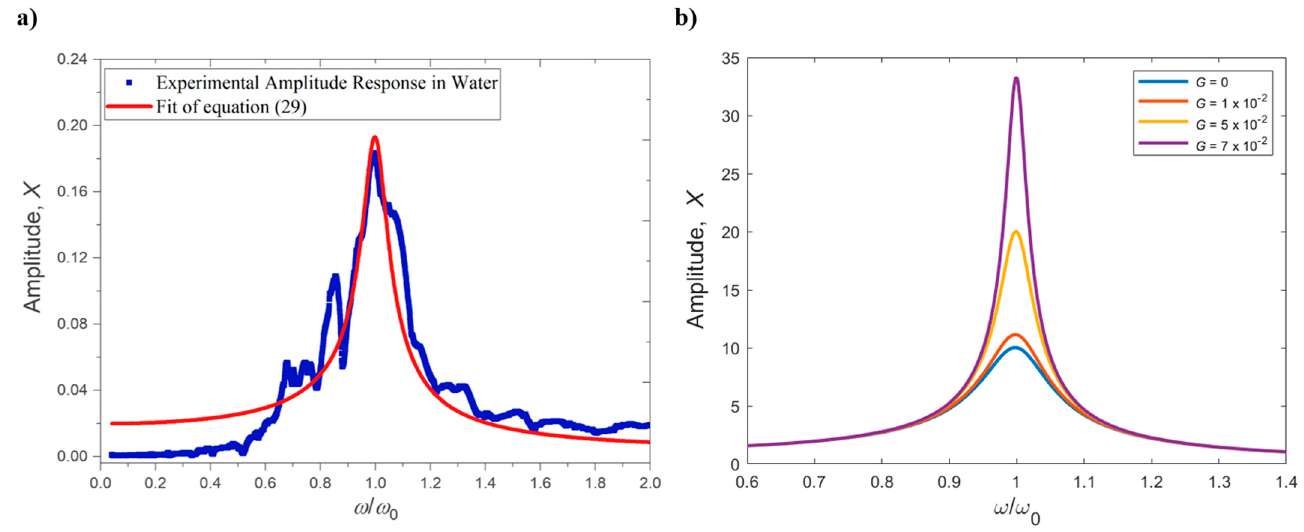
Figure 4. ( a ) Experimental amplitude response of an acoustically excited microcantilever oscillating in water, showing a noisy peak not accurately fitted by the theoretical amplitude curve; ( b ) dependence of the amplitude response of a microcantilever on the gain of the feedback loop in the Q -control method, for ω 0 = 1 rad/s, original Q = 10 (for G = 0), F 0 = 1 N/kg and φ = π m eff 2 rad.